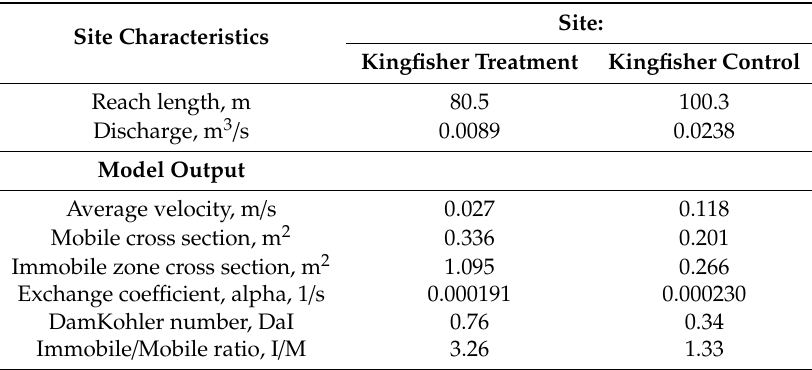
Table 4. Summary of NaCl tracer test parameters and results.